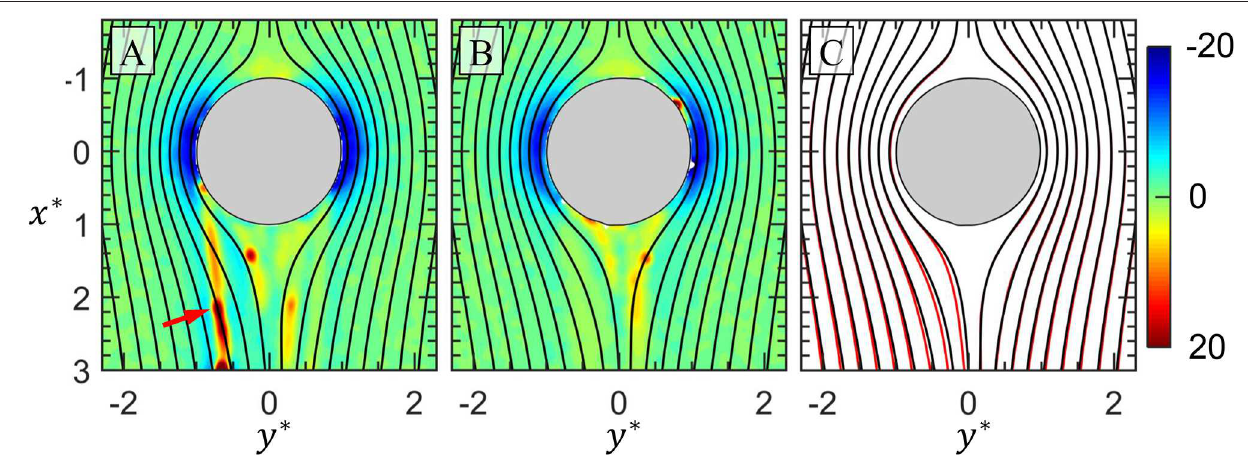
FIGURE 7 | In (A) contours of ∂ p * /∂ x * for the drop at 50min ( Figure 5F ) is plotted with streamlines overlaid. In (B) contours of ∂ p * /∂ x * around the same drop at 70min is shown with streamlines overlaid and originating at the same x -coordinates as (A) . A streamer indicated by the red arrow in (A) has detached in (B) . In (C) the streamlines from (B) (black lines) are plotted on top of the streamlines from (A) (red lines) to show the deviation in streamlines caused by the streamer indicated by the red arrow in (A)